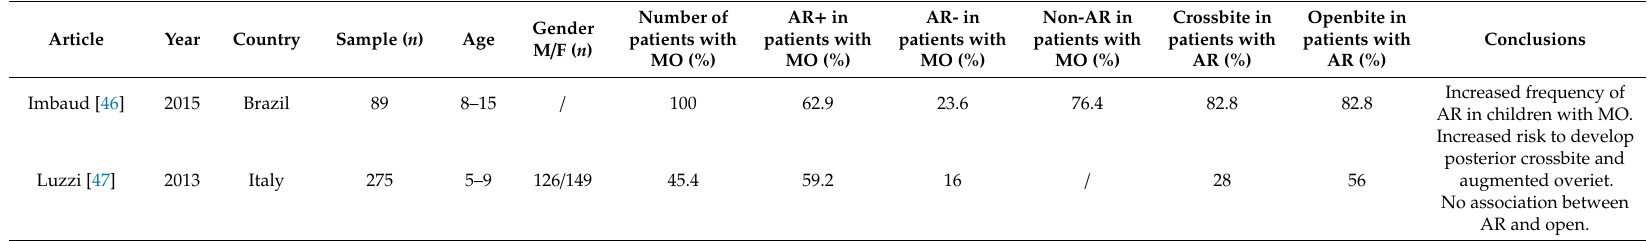
Table 3. Clinical characteristics of the studies evaluating rhinitis in pediatric patients with diagnosis of malocclusion. AR + indicates children with diagnosis of allergic rhinitis. AR- indicates children without allergic